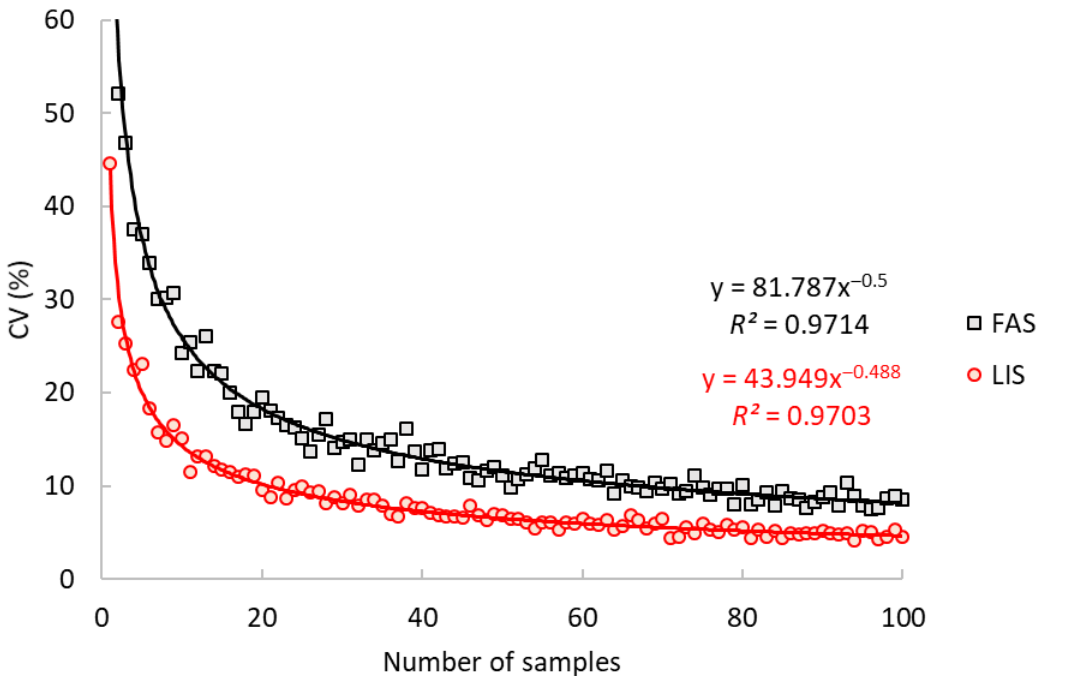
Figure 2. Sampling simulations from 1 to 100 plots for the Test Zone, and the corresponding coefficient of variation (CV) of the estimated volume for pieces from 0 to 4 cm in diameter for the fixed-area sampling methods (FAS: black squares, quadrats of 0.46 m 2 ) and line-intersect sampling method (LIS: red circles, 0.7 m transects). Mean of 100 simulations for each number of samples (squares and circles) and the fitted model (solid lines).